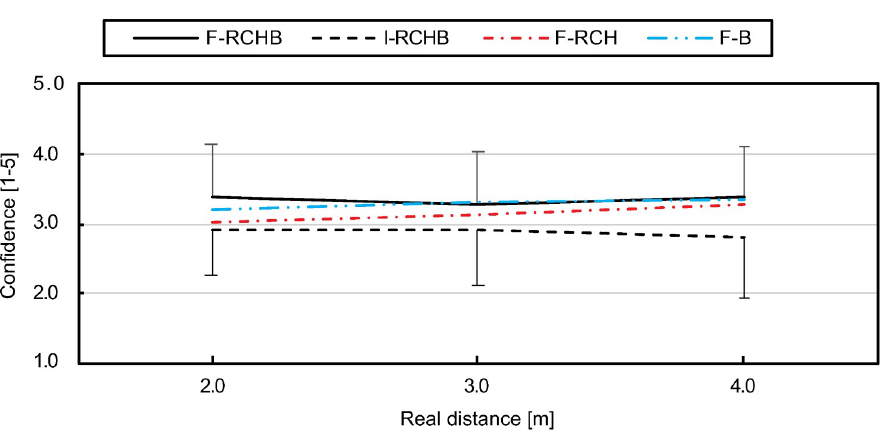
Fig 19. Confidence of prediction. Mean and standard deviation of the confidence of prediction depending on the real putting distance under the I-RCHB, F-RCHB, F-RCH, and F-B conditions.